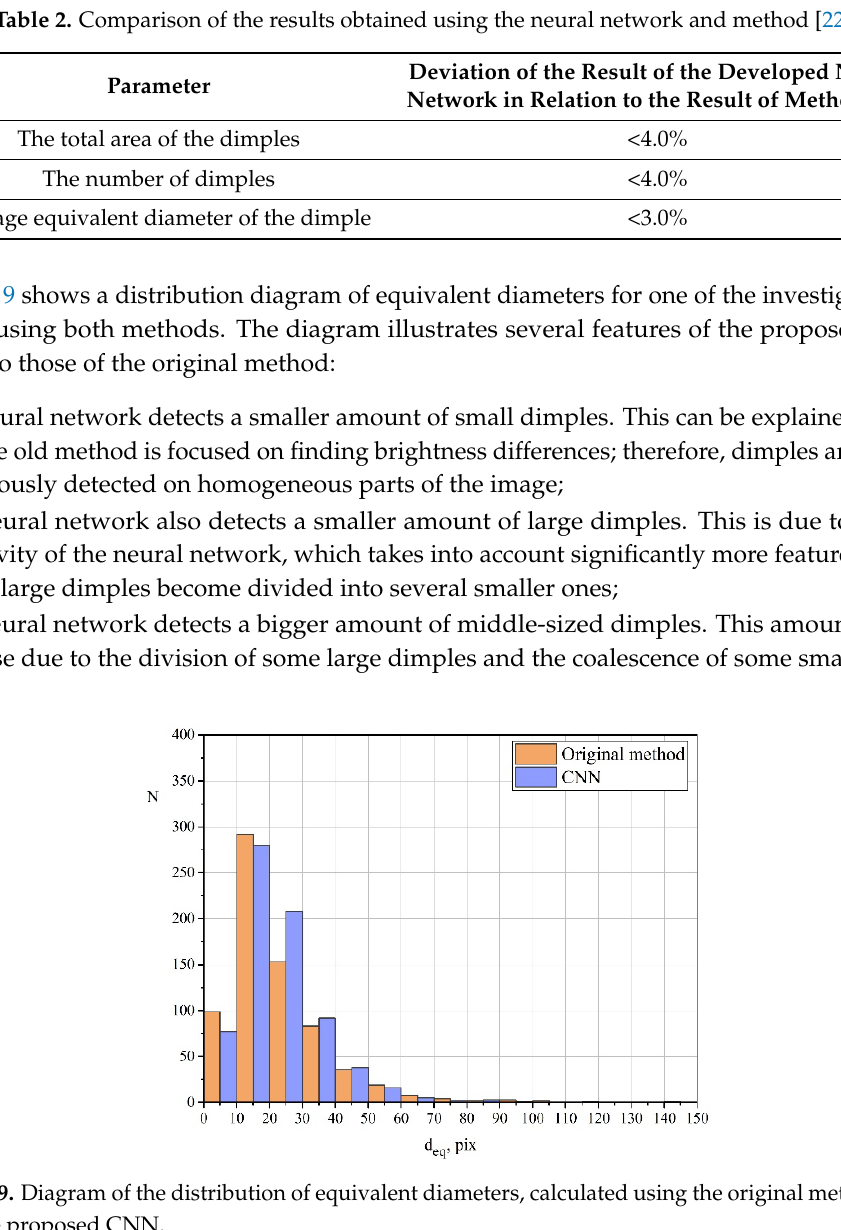
Table 2. Comparison of the results obtained using the neural network and method [22].